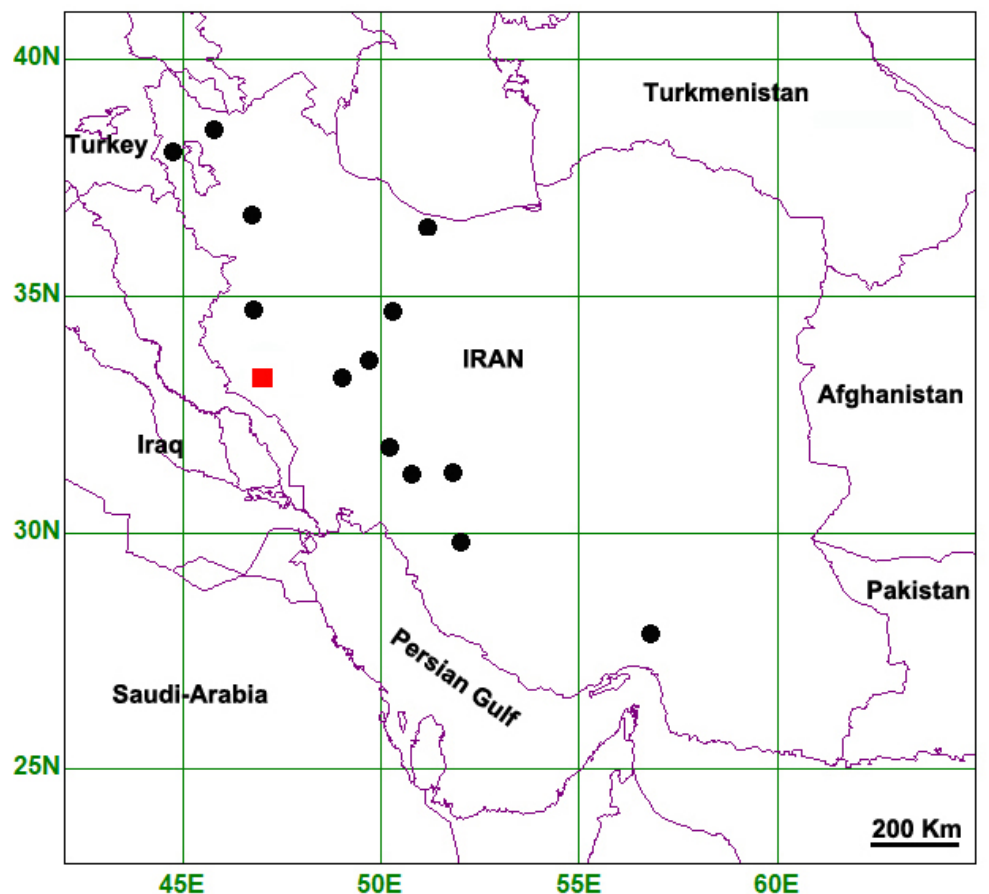
Figure 3. Distribution map of Teucrium elymaiticum Attar, Sotoodeh & Mirtadzadini, spec. nova (  ), and T. scordium subsp. scordioides Arcang. ( 